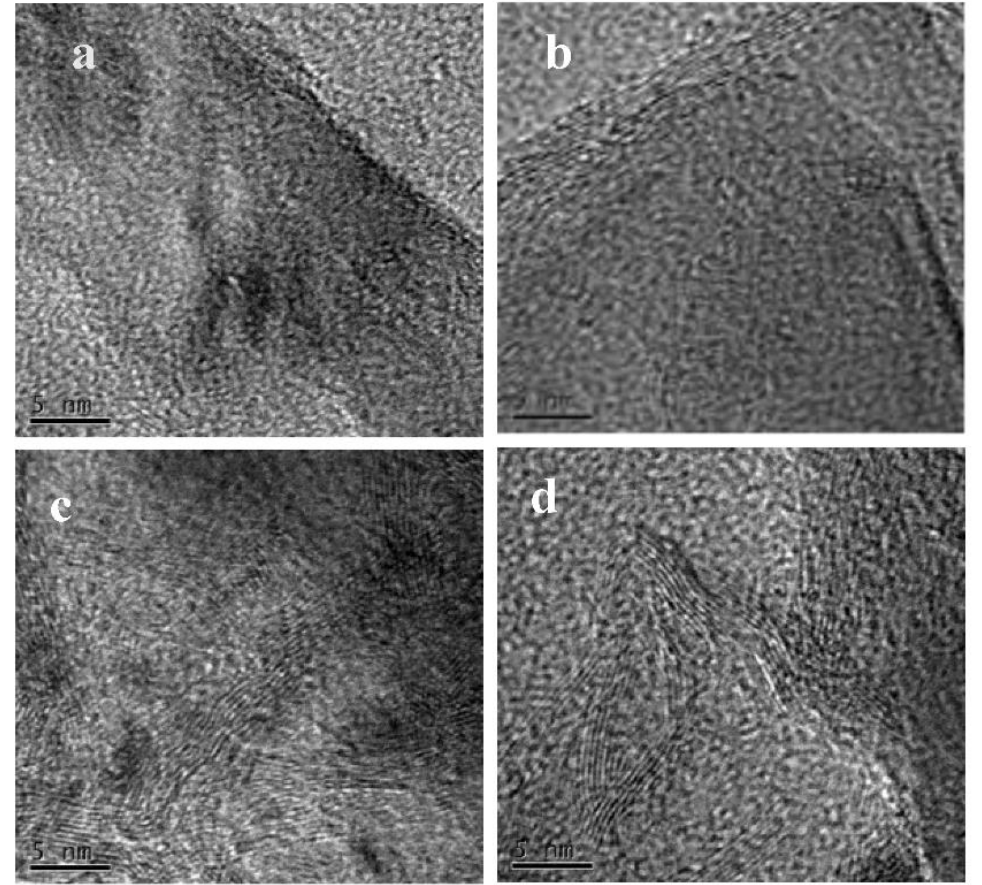
Figure 7. The TEM images of nanodiamond catalysts calcinated at 500 °C ( a ), 700 °C ( b ), 900 °C ( c ), and 1100 °C ( d ). Reprinted from Ref. [10]. Copyright 2022 by the authors. Licensee MDPI, Basel,